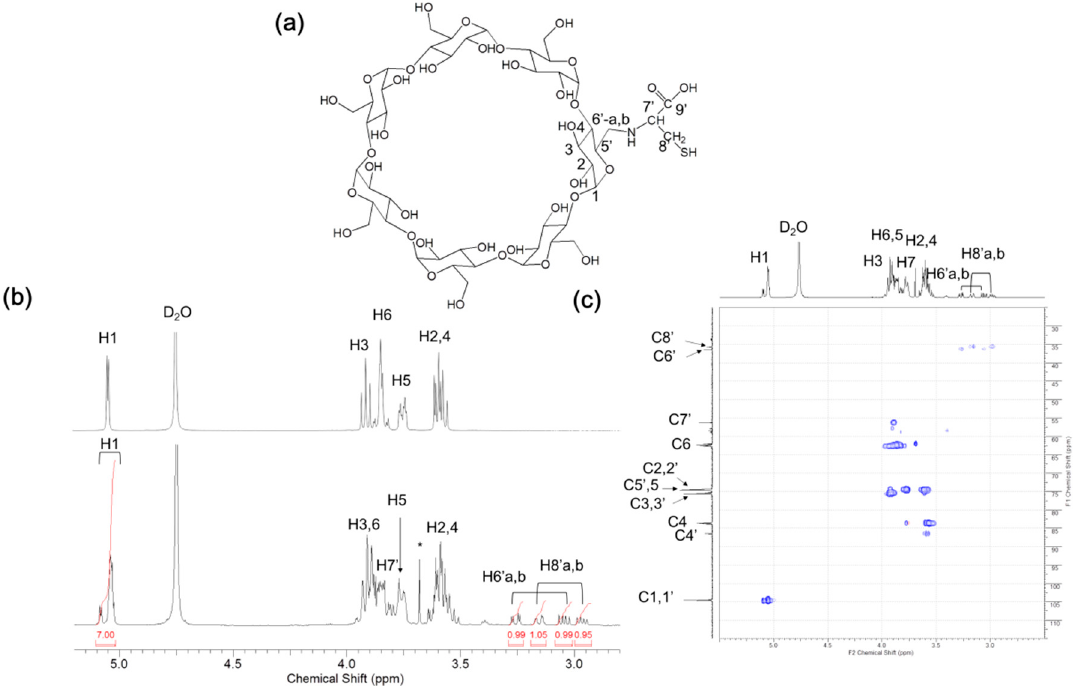
Figure 2. ( a ) Chemical structure of cysteinyl β -CD; ( b ) 1 H-NMR spectra of β -CD ( top ) and cysteinyl β -CD ( bottom ); ( c ) HSQC spectrum of cysteinyl β -CD. Solvent: D 2 O.